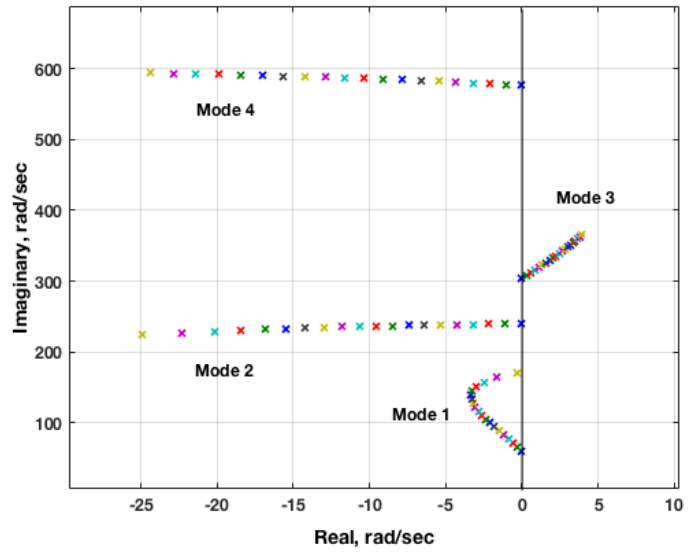
Figure 18. ROM aeroelastic root locus plot for M = 1.141, inviscid